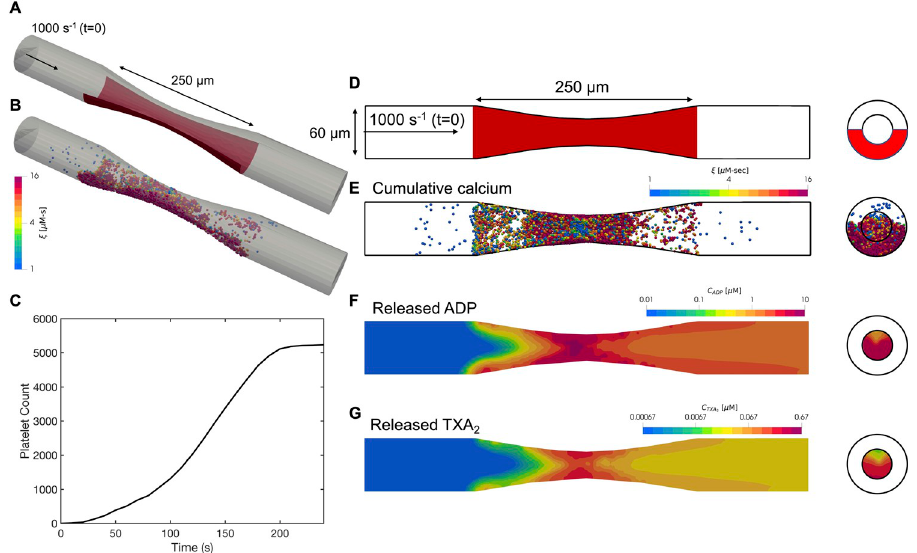
Fig 7. Simulation results of platelet aggregation under pathological shear rates in a stenosis at the time of vessel occlusion. Schematic of the stenotic geometry: (A) oblique view and (D) side view. Inlet and outlet of the stenosis maintained at a constant pressure drop across the length of the geometry that corresponded to an initial inlet wall shear rate of 1000s -1 . Surface collagen: red bar. (B,E) Platelet activation (blue indicates inactivated and red, highly activated) and deposition at occlusion time. (C) Dynamics of platelet aggregate density observed over time. Released (F) ADP and (G) TXA 2 contours plotted along the along the center of the tube at the time of occlusion.